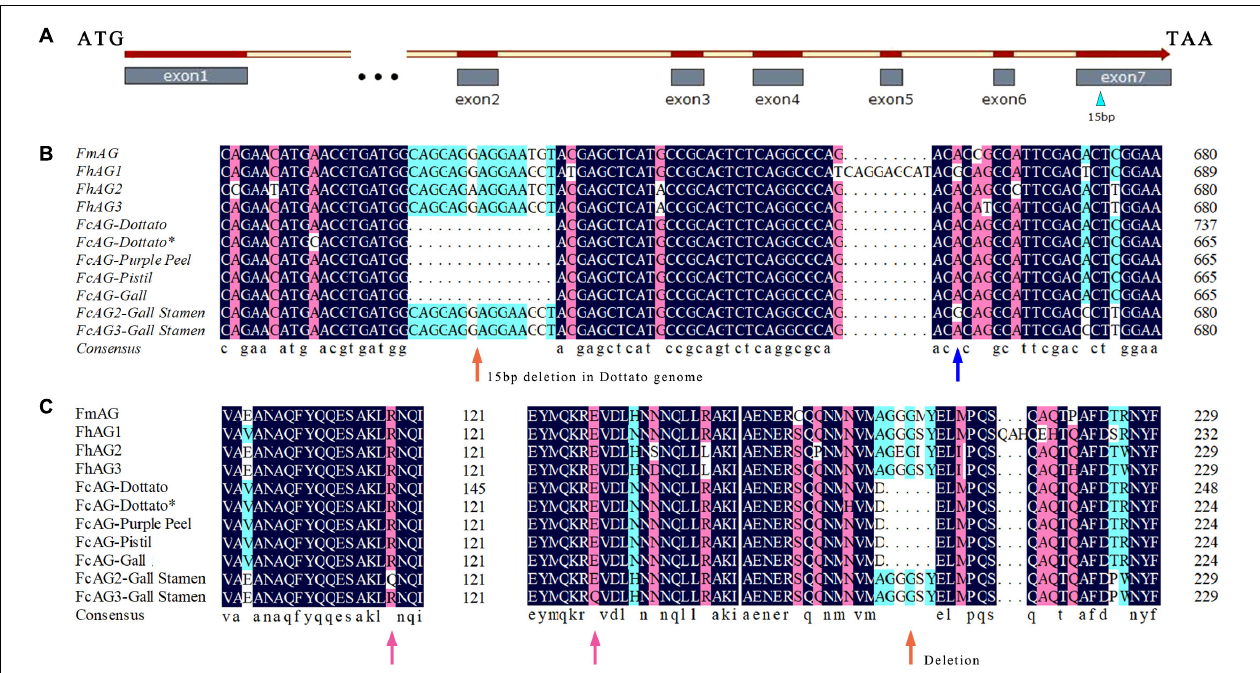
FIGURE 1 | AG genes of different Ficus species. (A) Gene structure of FcAG s; the male–female-differentiating 15 bp in the 7th exon is indicated by a blue triangle. (B) The 15-bp deletion (orange arrow) is common to the conserved AG genes, whereas the 15 bp are present in two other AG genes expressed in galls and stamens. Blue arrow indicates base difference. (C) Some synonymous and missense mutations (pink arrows) revealed by amino acid sequence prediction of the AG